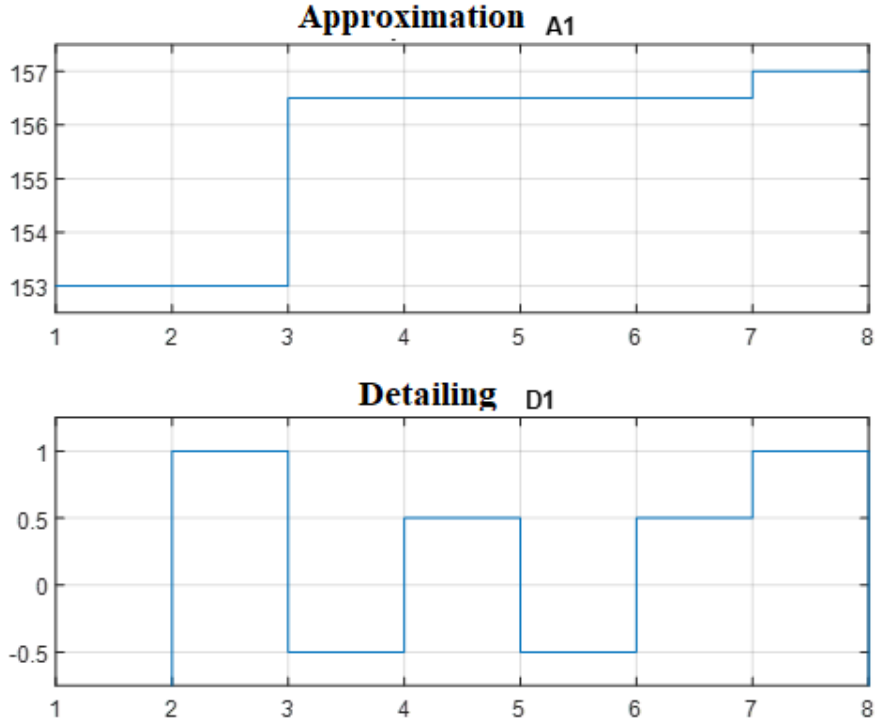
Figure 1. Application of the wavelet ‘db1’ for single-level vector processing y.